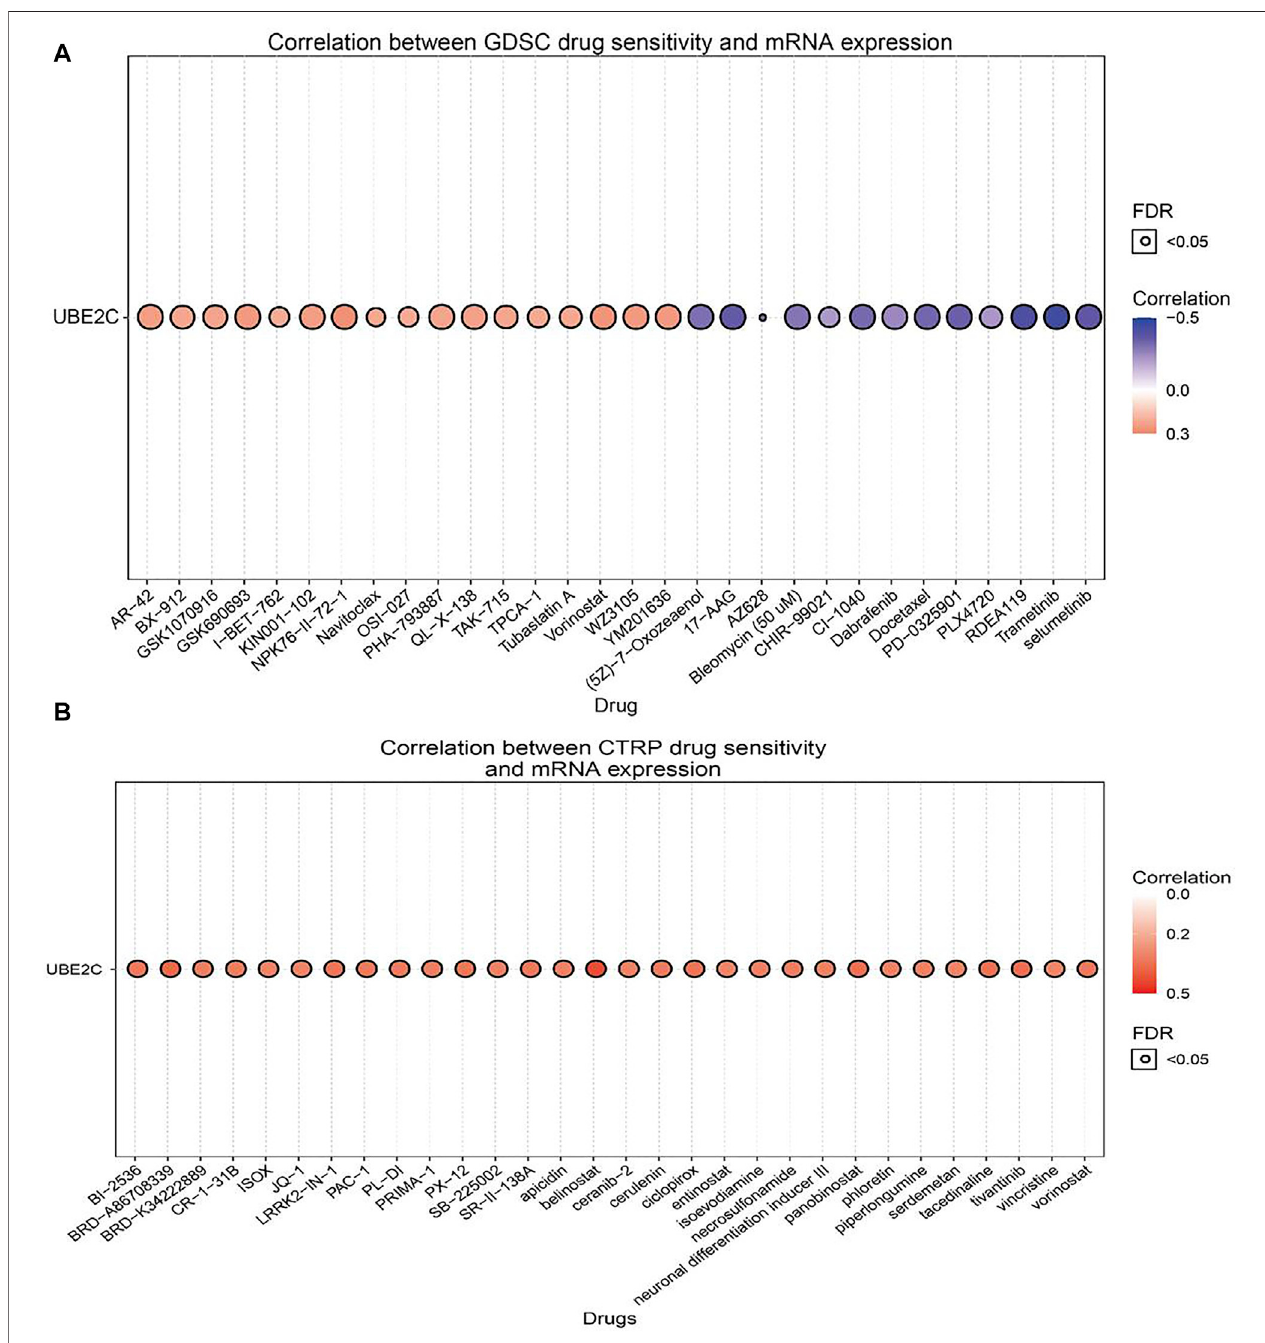
FIGURE 7 | Analysis of the correlation between UBE2C expression and drug sensitivity in diverse human cancer. (A) The correlation between UBE2C expression and drug sensitivity in diverse human cancer analysis by the GDSC database. (B) The correlation between UBE2C expression and drug sensitivity in diverse human cancer analysis by the CTRP database. * p < 0.05, ** p < 0.01, *** p < 0.001.